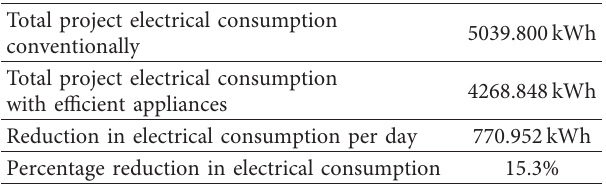
Figure 9: Difference between energy consumption when con- ventional loads are used and when improvised appliances are used for 1BHK, 2BHK, and 3BHK. Table 10: Energy usage calculations.